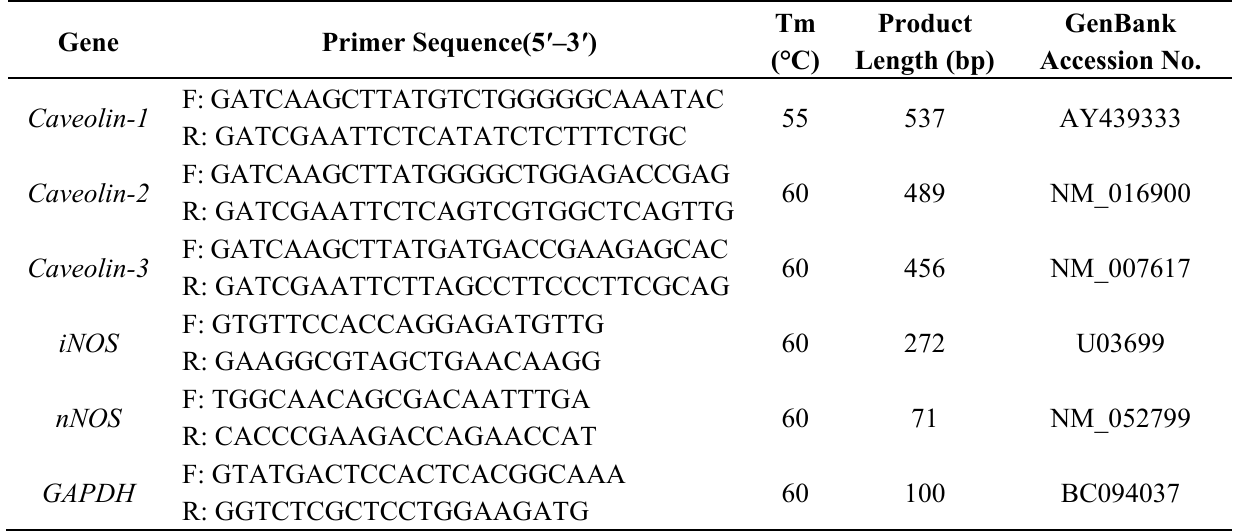
Table 2. Oligonucleotide primers used for RT-PCR in this